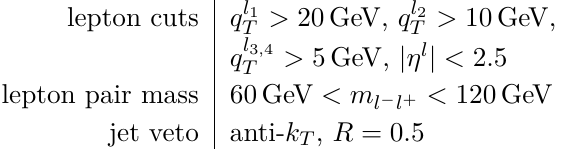
Table 7 . Fiducial cuts used for the ZZ analysis, taken from the CMS study in ref. [40].